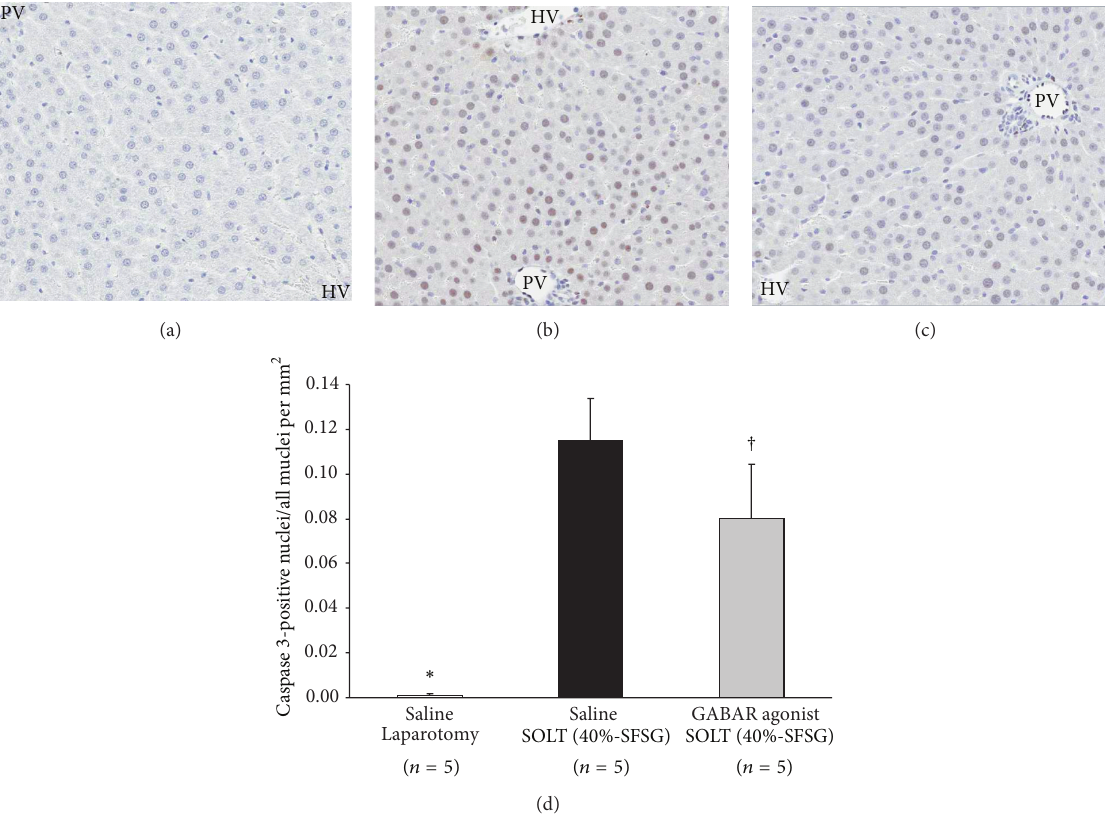
Figure 4: Immunohistological assessment by caspase 3. (a) Laparotomy with saline: caspase 3, × 100. (b) SOLT with saline: caspase 3, × 100. (c) SOLT with GABAR agonist: caspase 3, × 100. (d) The ratio of caspase 3-positive nuclei. There were significant differences between laparotomy and SOLT with saline ( 𝑃 < 0.05 ∗ ) and between SOLT with saline and SOLT with GABAR agonist ( 𝑃 < 0.05 † ). Caspase, cysteine aspartic acid protease; GABAR, 𝛾 -aminobutyric acid receptor; HV, hepatic vein; SFSG, small-for-size graft; SOLT, split orthotopic liver transplantation; and PV, portal vein.